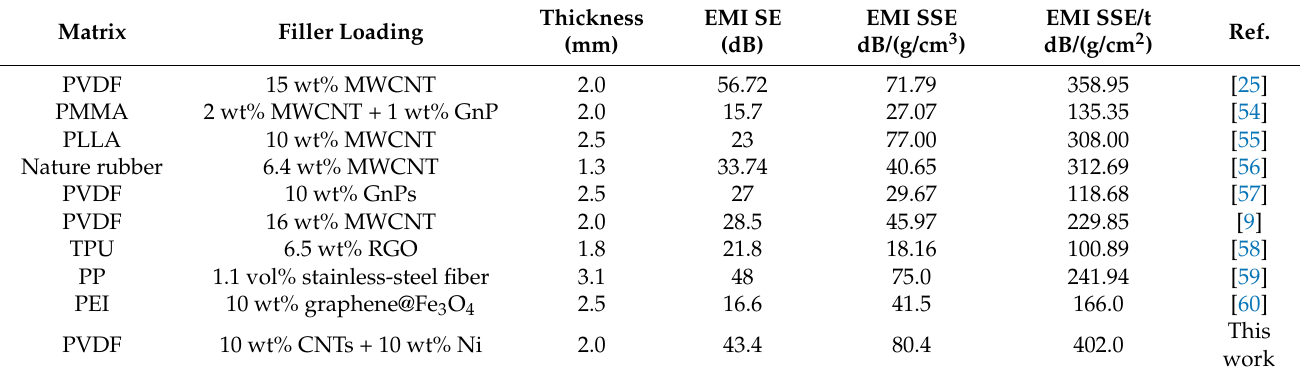
Table 2. The EMI shielding effectiveness of porous composites reported in recent